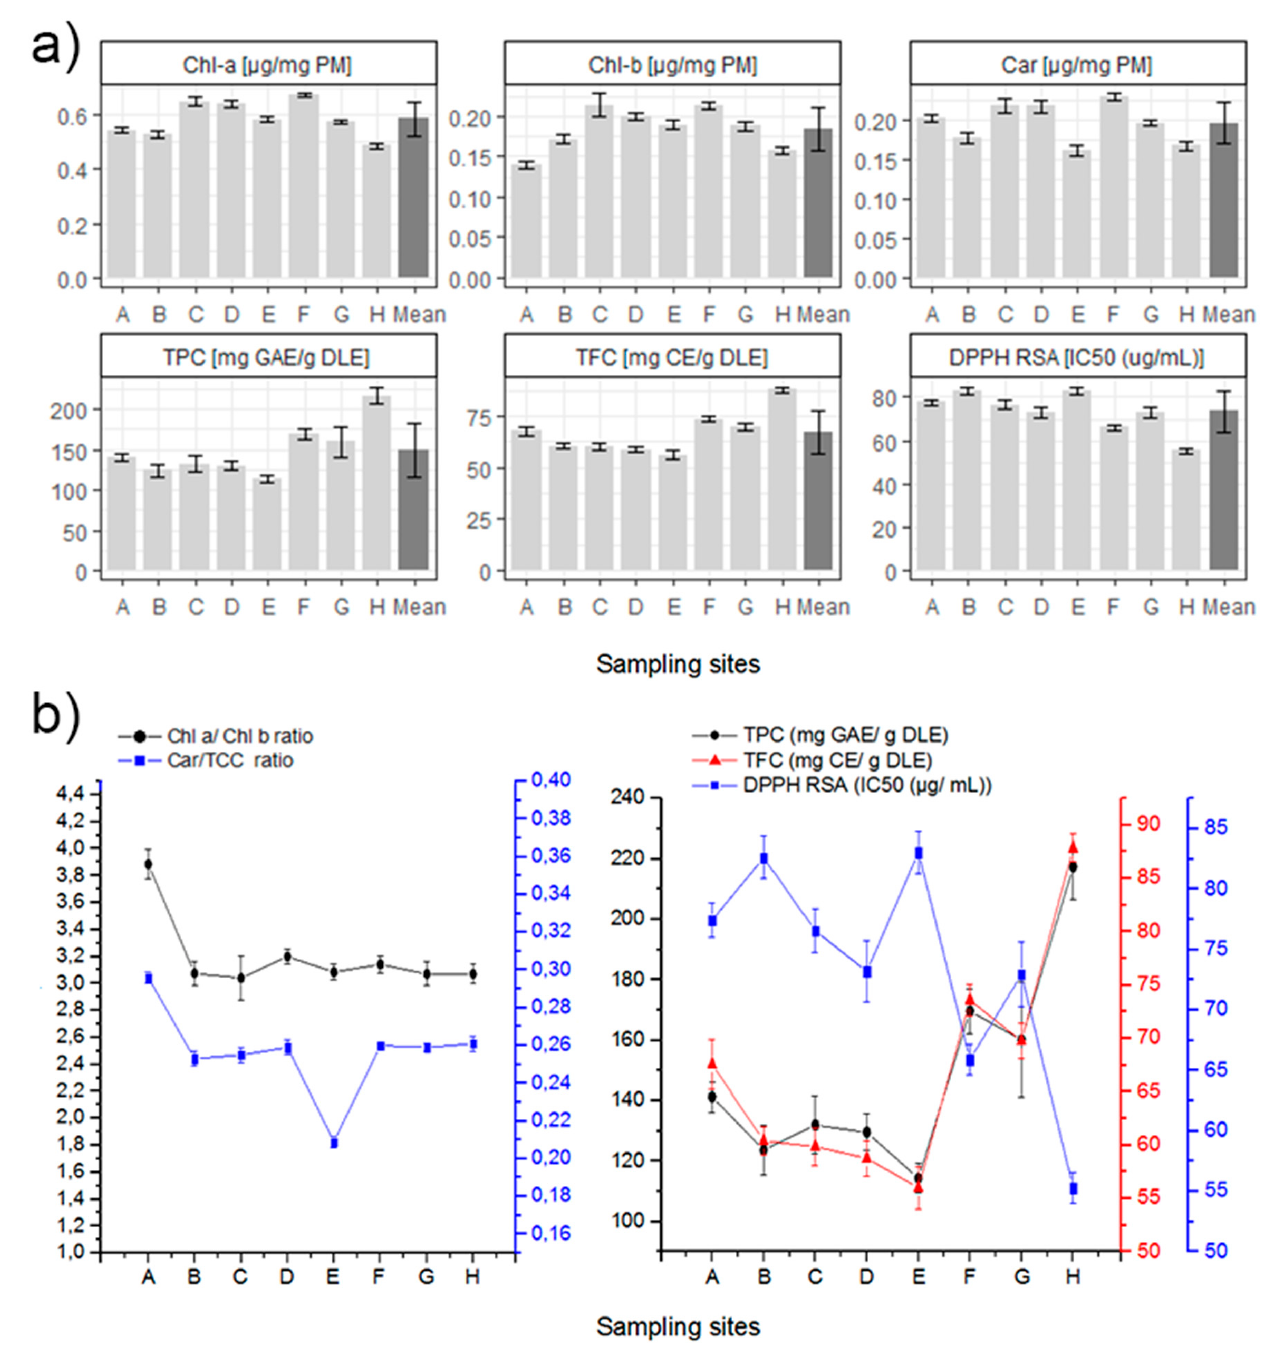
Figure 3. ( a ) Summary of laboratory results for each biochemical in all the sampling sites. Mean is included in darker gray, and 1 ± standard deviation is specified for each value. ( b ) Left. Chlorophyll-a/Chlorophyll-b and Carotenoids/Total Chlorophyll Content ratio for each sampling site. ( b ) Right. Relationships between the total phenolic content (TPC), total flavonoid content (TFC) and the DPPH free radical scavenging activity at each sampling site.